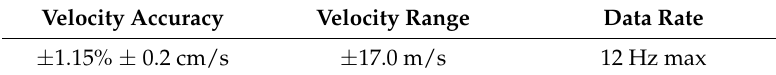
Table 6. The main parameters of the DVL.